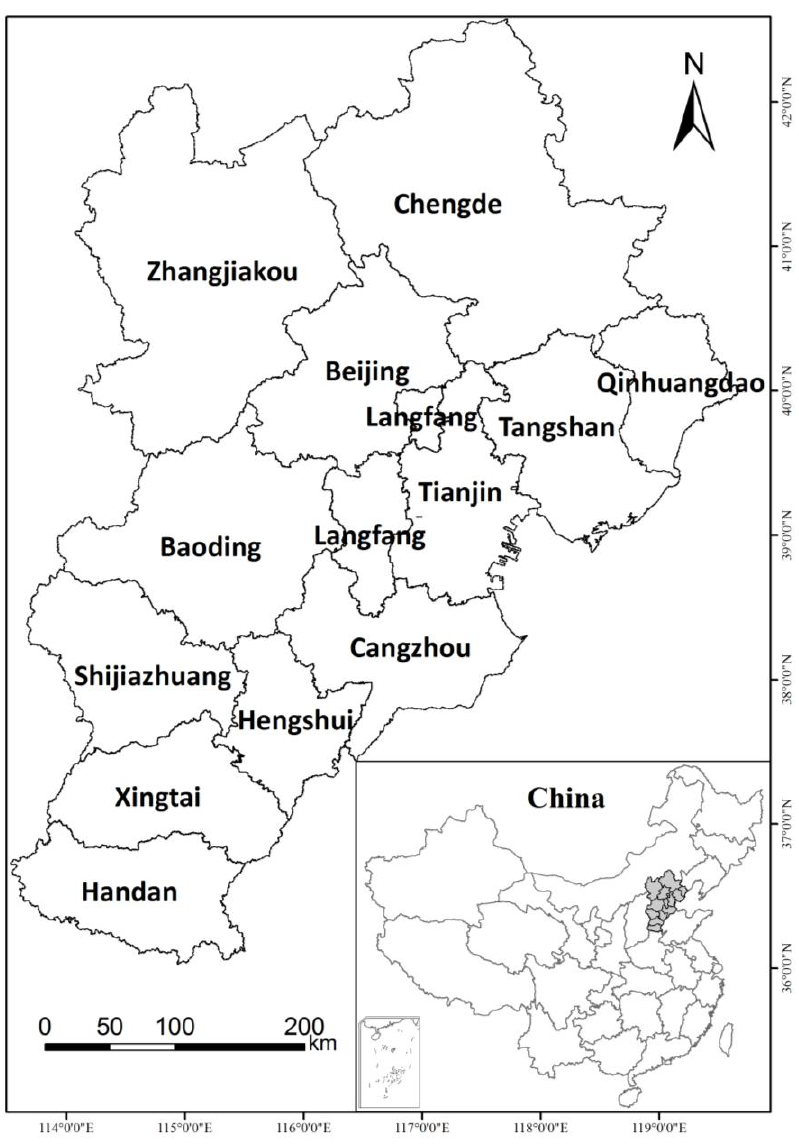
Figure 1. Location and range of the BTH region, China.